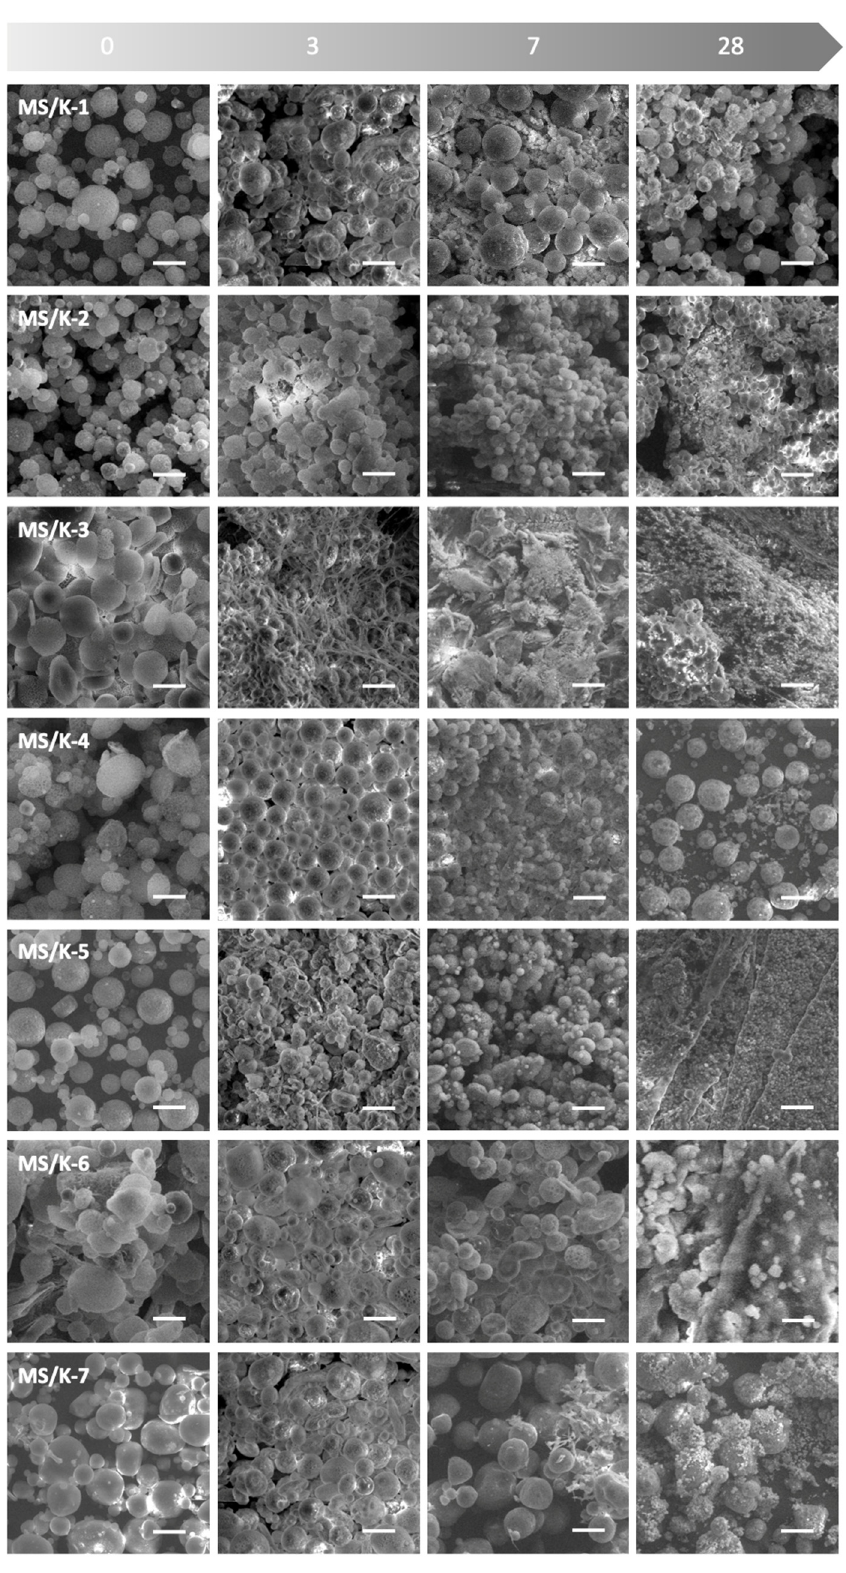
Figure 7. Degradation resistance of MS/Ks in a physiological-like environment (PBS 1X, pH 7.4, 37 °C) up to 28 days as observed via SEM. Scale bar: 50 µm; magnification: 500×.